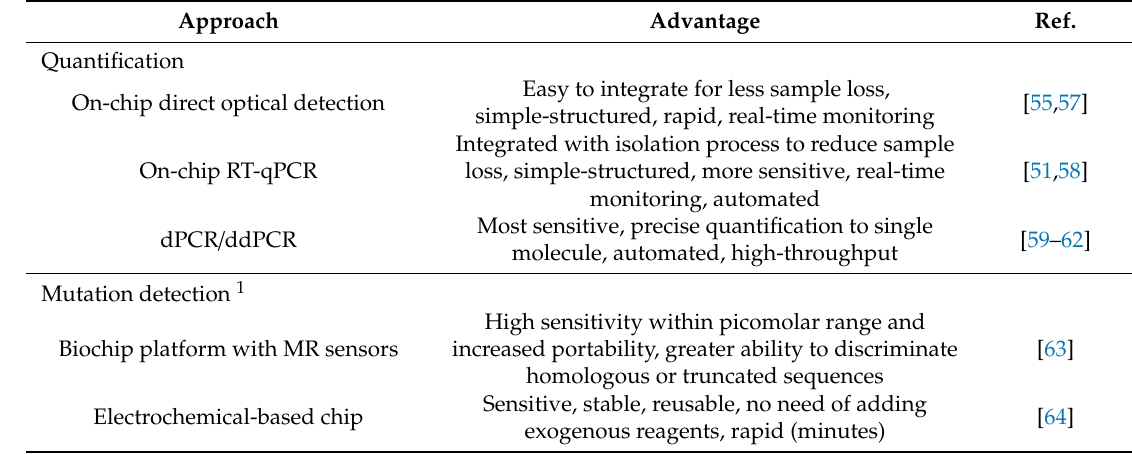
Table 2. Summary of microfluidic techniques for cfDNA quantification and mutation detection.